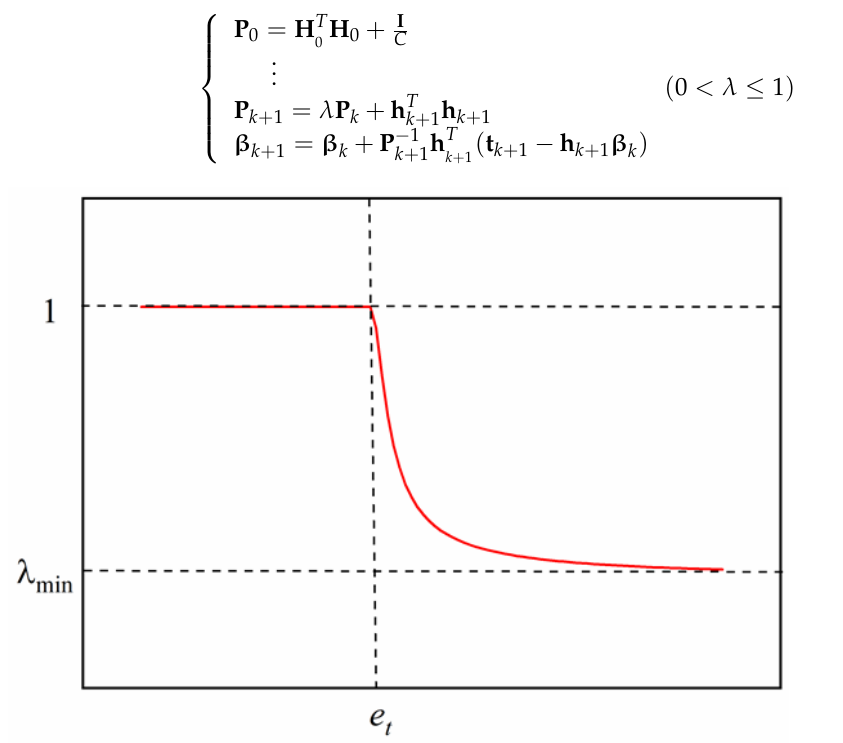
Figure 3. Schematic diagram of the forgetting factor update function.